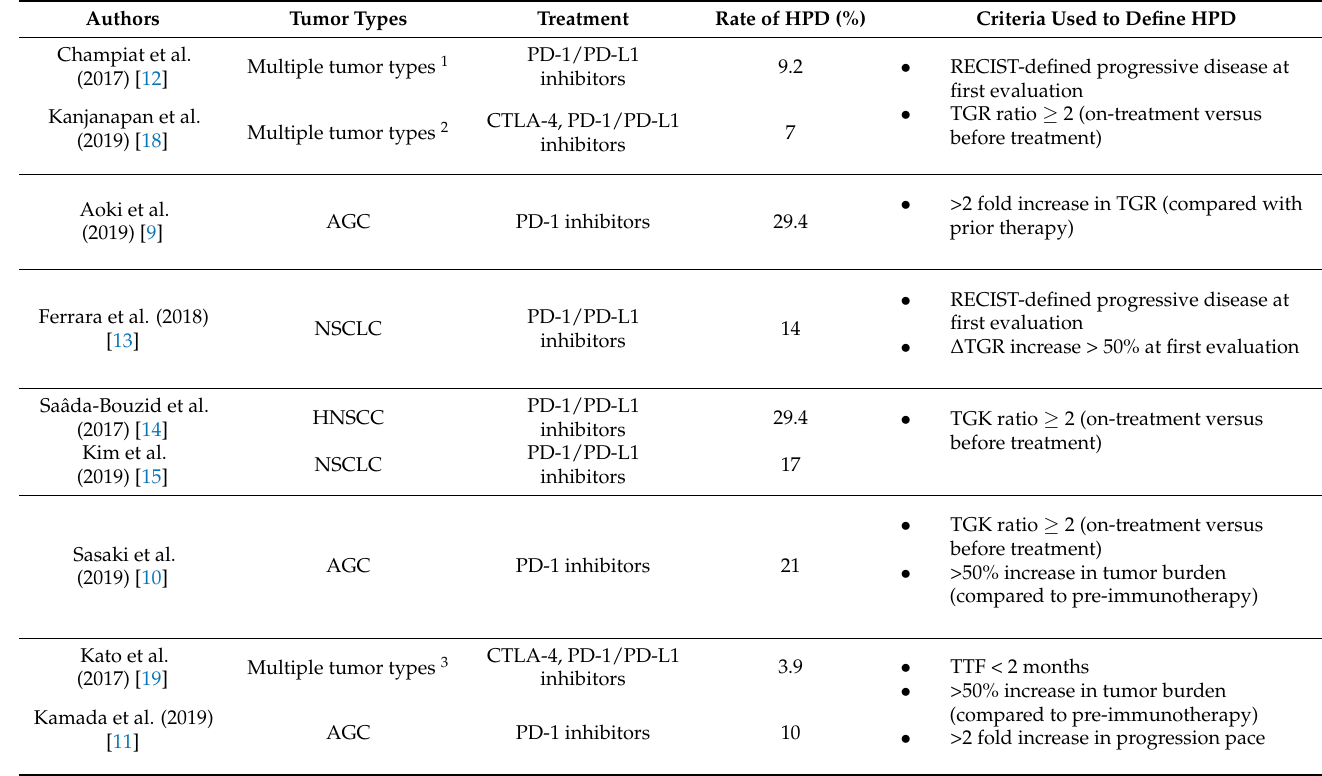
Table 1. The incidence of hyperprogression after ICI therapy and definitions of HPD in different